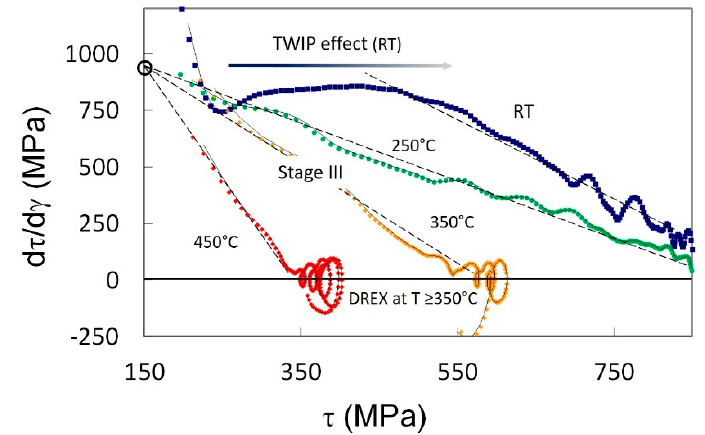
Figure 1. Fe-22%Mn-0.6%C twinning-induced plasticity (TWIP) steel. Strain-hardening rate (SHR) in shear vs. macroscopic shear flow stress from torsion tests at several temperatures and 1.4 × 10 − 3 s − 1 shear strain rate. At room temperature (RT), the TWIP activity starts after a short Stage III activity and produces a transient SHR increase. Deformation twinning at this strain rate is irrelevant for T > 150 ◦ C. See ref. [6] for more results on this steel.